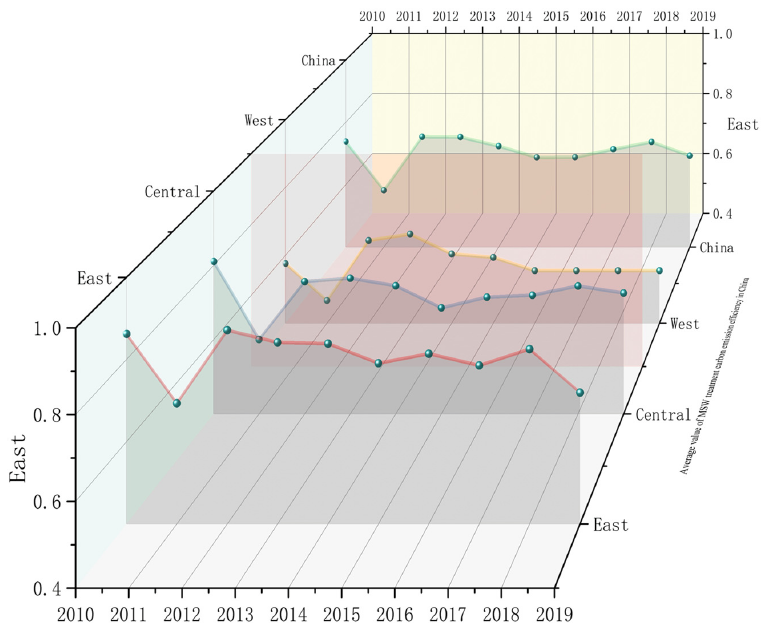
Figure 2. Mean of the MSW treatment carbon emission efficiency for the whole of China and for the three regions.